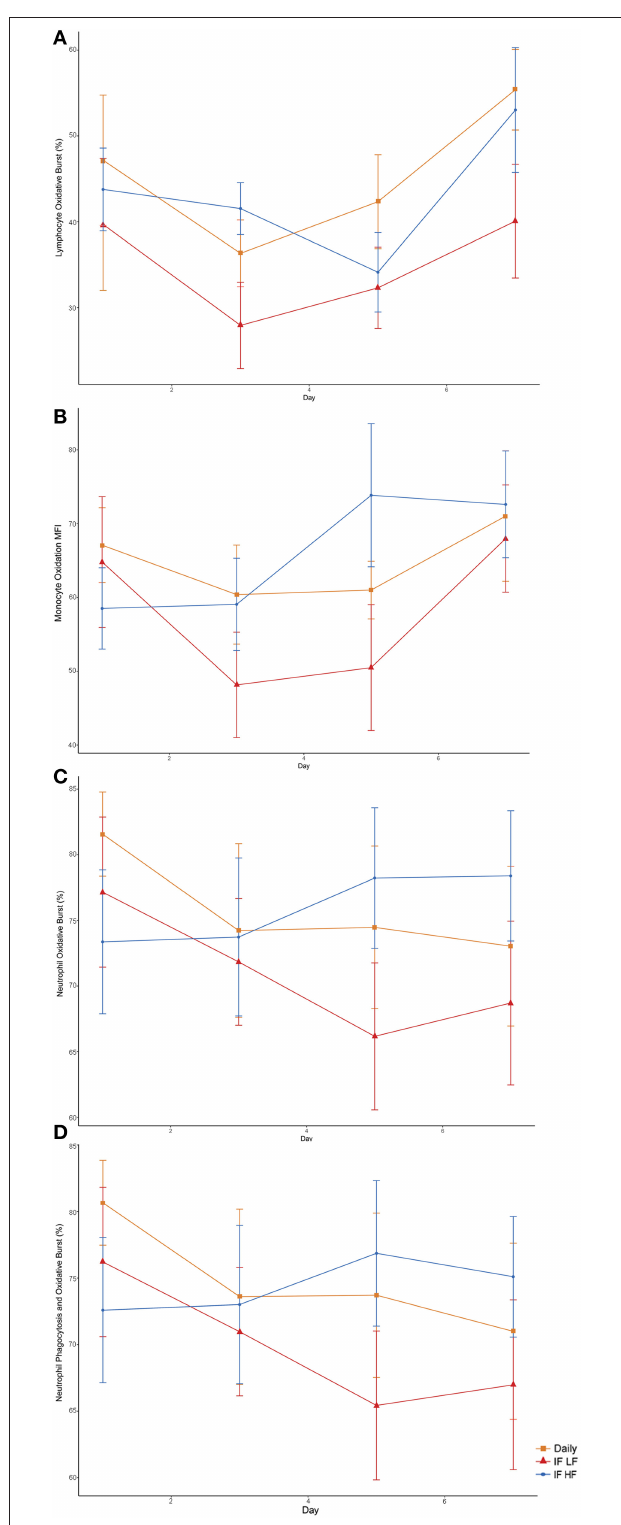
FIGURE 10 | Differences in immune parameters in 10 dogs fed daily (square), and intermittently fasted on a low fat (triangle) and a high fat diet (circle) in